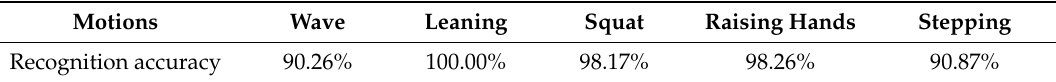
Table 4. The recognition accuracy comparison of different movements.